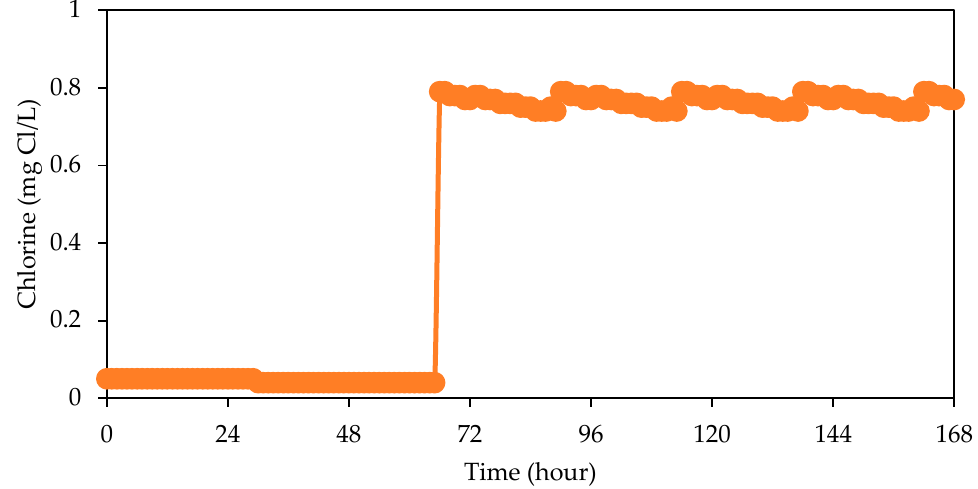
Figure 8. Free chlorine value at Mukono Health Centre (No. 13), lowest value for the system.